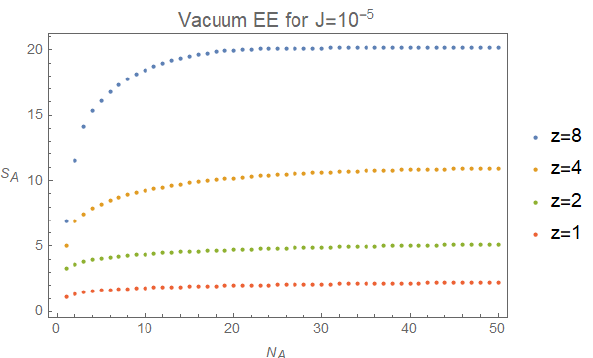
Figure 3: Plot of vacuum EE as a function of the size N of the subinterval A for fixed J = 10 − 5 and A different fixed values of z . For the z = 1 case, the plot matches with the Casini-Huerta prediction with > z to central charge c = 1. There also appears to be a crossover from logarithmic growth when N A < z , as is best visible with the z = 8 data linear growth when N A